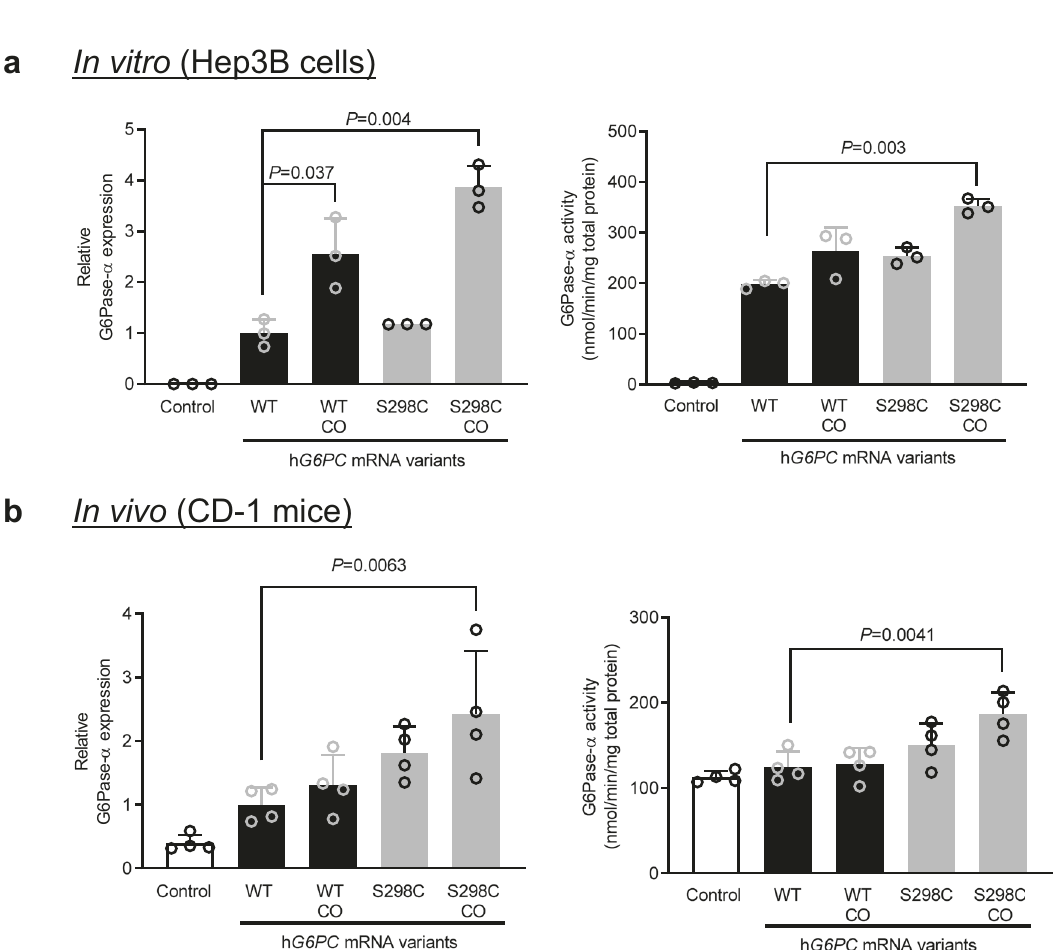
Fig. 2 Effect of codon optimization on expression and activity of h G6PC mRNAs. a hG6Pase- α protein expression (left panel) and enzymatic activity (right panel) of wild-type hG6PC (WT), codon optimized wild-type h G6PC (WT_CO), hG6PC_S298C (S298C), and codon optimized hG6PC_S298C (S298C_CO) mRNAs evaluated in Hep3B cells. Control cells were treated with eGFP mRNA. Data were presented as mean ± SD of n = 3 biologically independent samples. b hG6Pase- α protein expression (left panel) and enzymatic activity (right panel) of WT and codon optimized h G6PC mRNAs as evaluated in male CD-1 mice. Control animals were treated with eGFP mRNA. Data were presented as mean ± SD of n = 4 mice. For statistical analysis, raw values were Log2 transformed and subjected to one-way ANOVA, followed by the Dunnett ’ s multiple comparisons test, compared to the non-codon optimized WT hG6PC mRNA. Statistically signi fi cant P values ( p ≤ 0.05) are shown in the graphs. Source data are provided as a Source Data activity both in Hep3B cells (Fig. 2a) and in livers of WT (CD-1) mice (Fig. 2b). Of note, in CD-1 mice, the combination of protein variant S298C and codon optimization (S298C_CO mRNA) resulted in a more signi fi cant improvement in both hepatic protein expression and enzymatic activity (Fig. 2b).